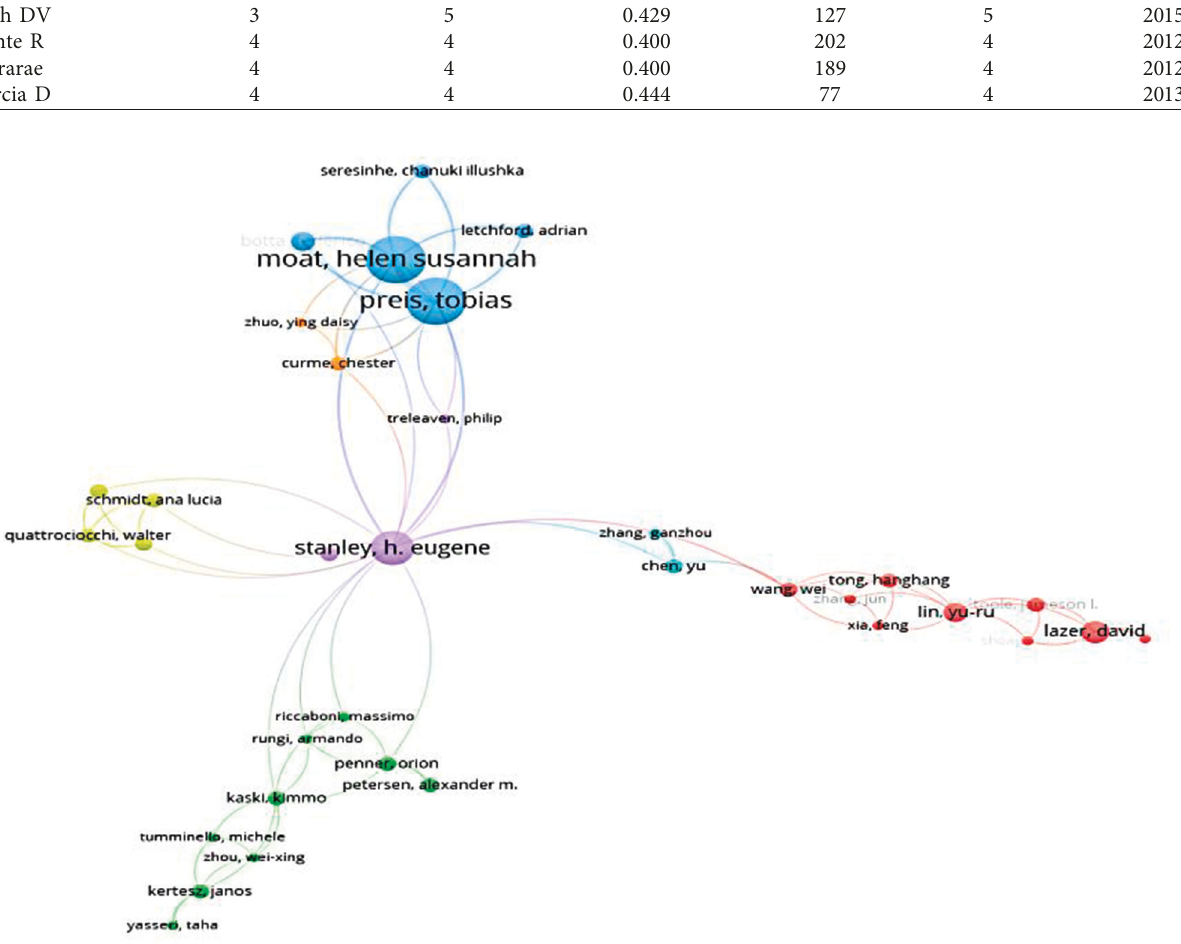
Figure 5: Collaborative network of scholars related to computational social science.